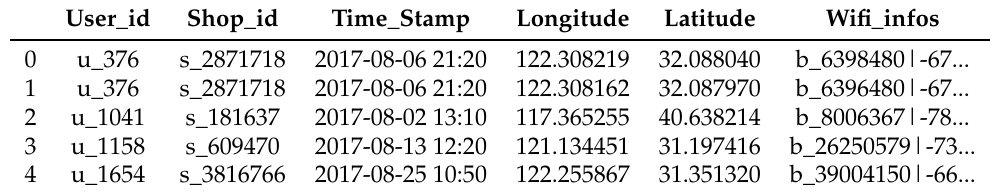
Table 2. Part of the transaction